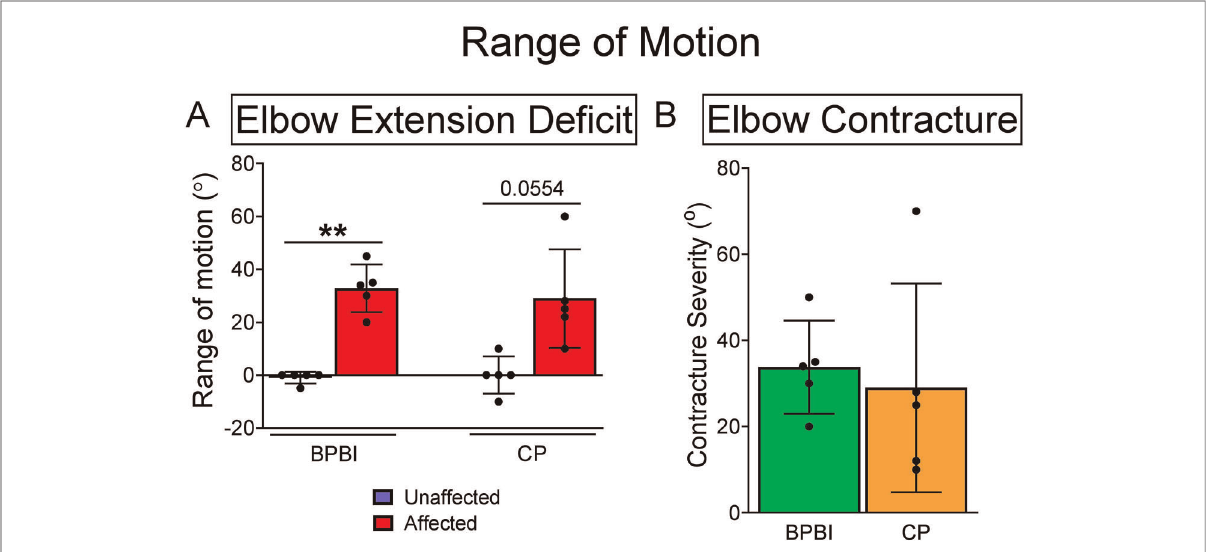
FIGURE 2 Elbow range of motion in BPBI and CP subjects. ( A ) Maximum passive elbow extension de fi cit in degrees for both BPBI and CP subjects, where full extension equals 0 degrees and hyperextension is negative. All subjects lacked at least 10 degrees from full extension on the affected sides. ( B ) Elbow fl exion contracture severity, de fi ned as the difference in maximum passive extension between affected and unaffected sides. All subjects had at least a 10 degree fl exion contracture on the affected side. ** p